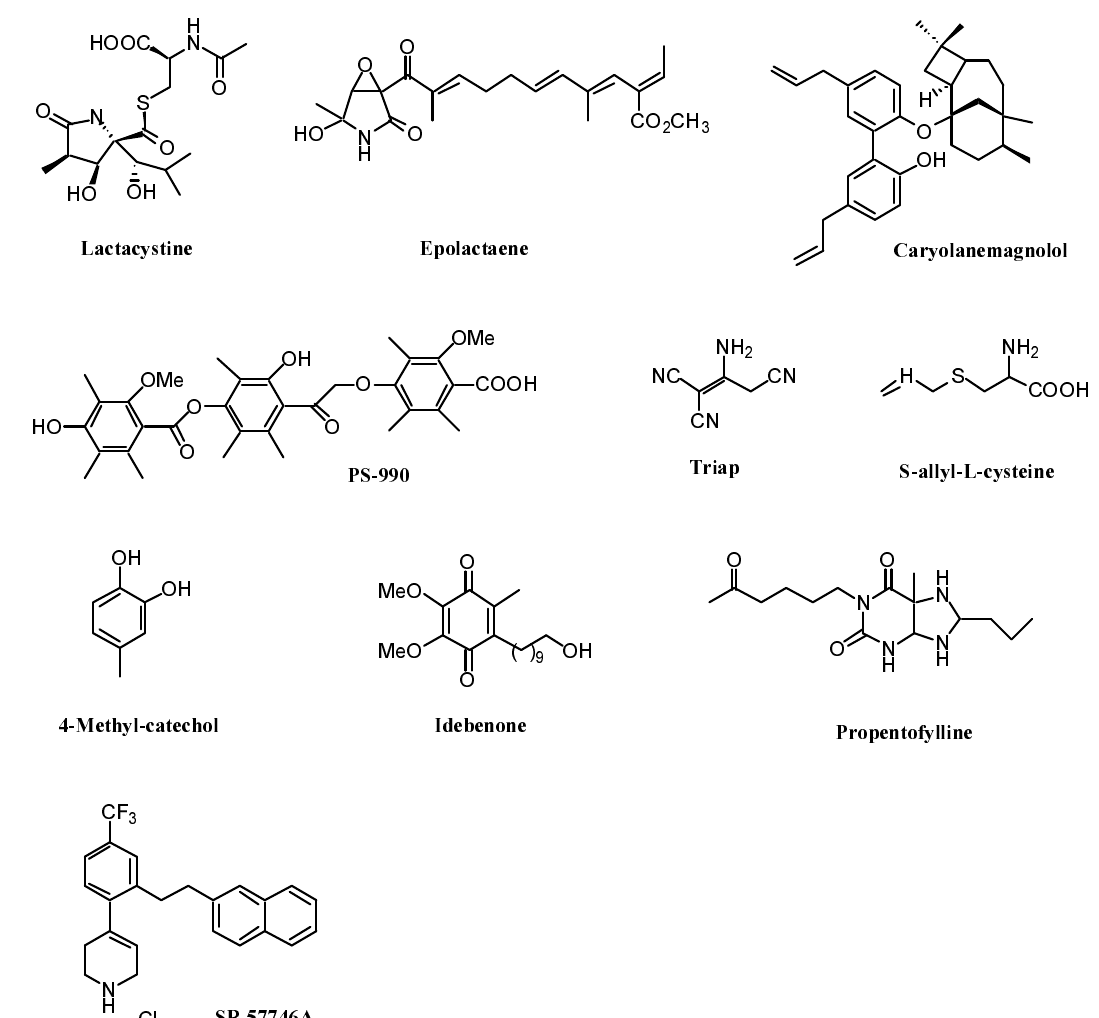
Figure 1 . Structure of non-peptide molecules with NF-like and/or NF-releasing